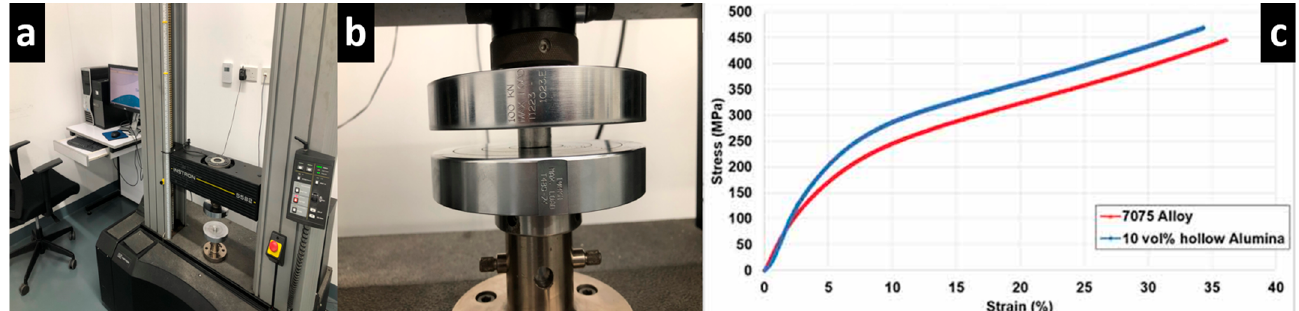
Figure 2. ( a ) Different views of compression test set-up; ( b ) a close-up view of 7075 Aluminum sample kept between pressure plates during compression; ( c ) Stress-strain compression behavior of 7075 Aluminium. Table 3. Properties of the cutting tool [26,27].